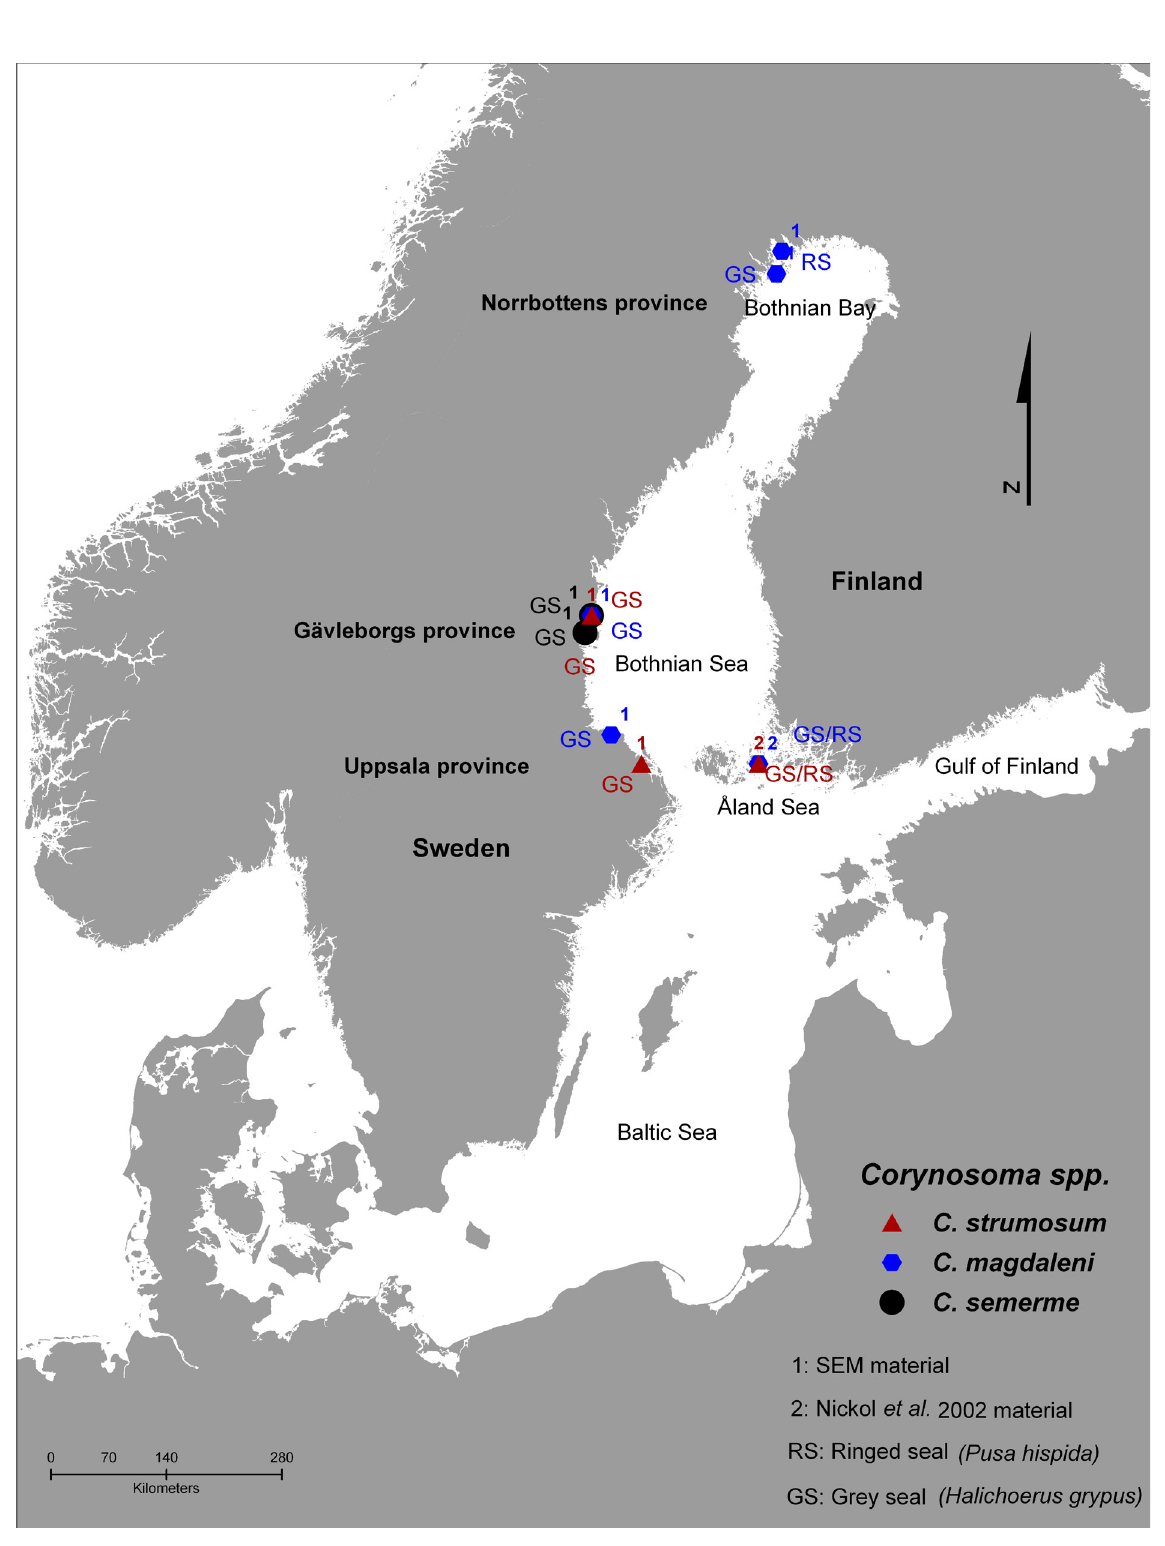
Fig. 1. Map of sampling